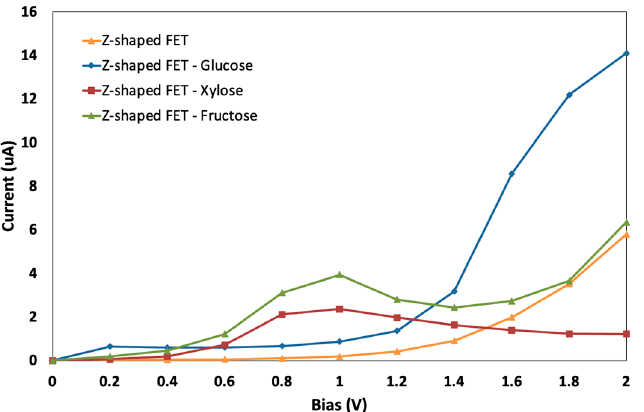
Figure 8. Current-Voltage characteristics for the GNR FET (orange), for the GNR FET with glucose (blue), for the GNR FET with xylose (red) and for the GNR FET with fructose (green).